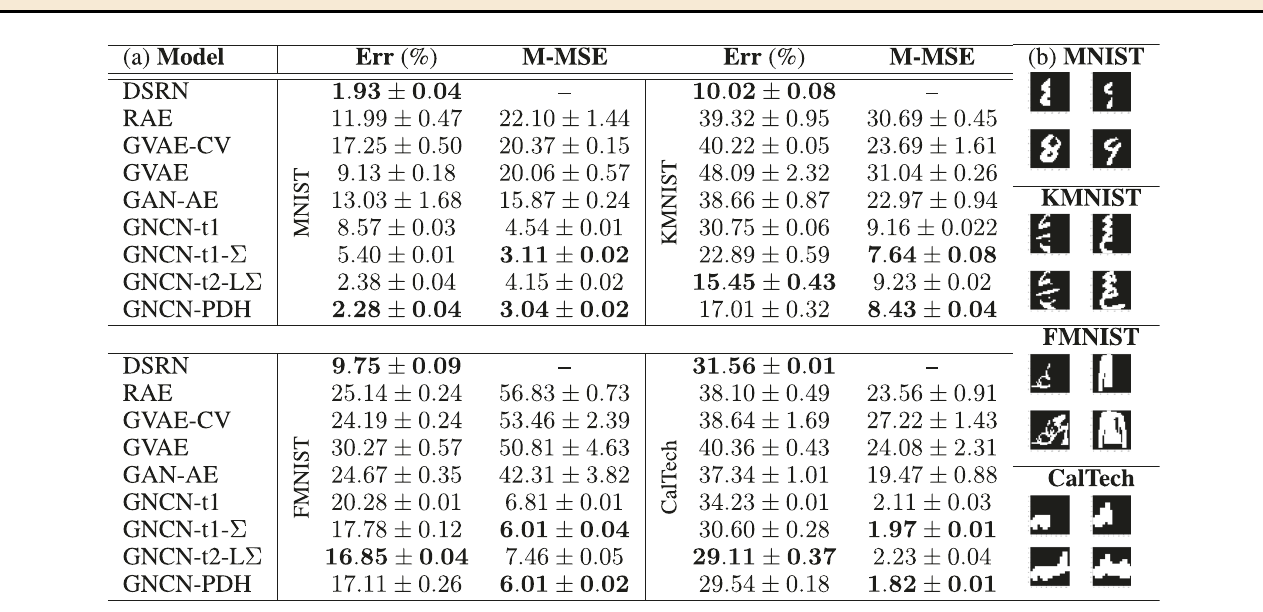
Table 2 Downstream performance across datasets.